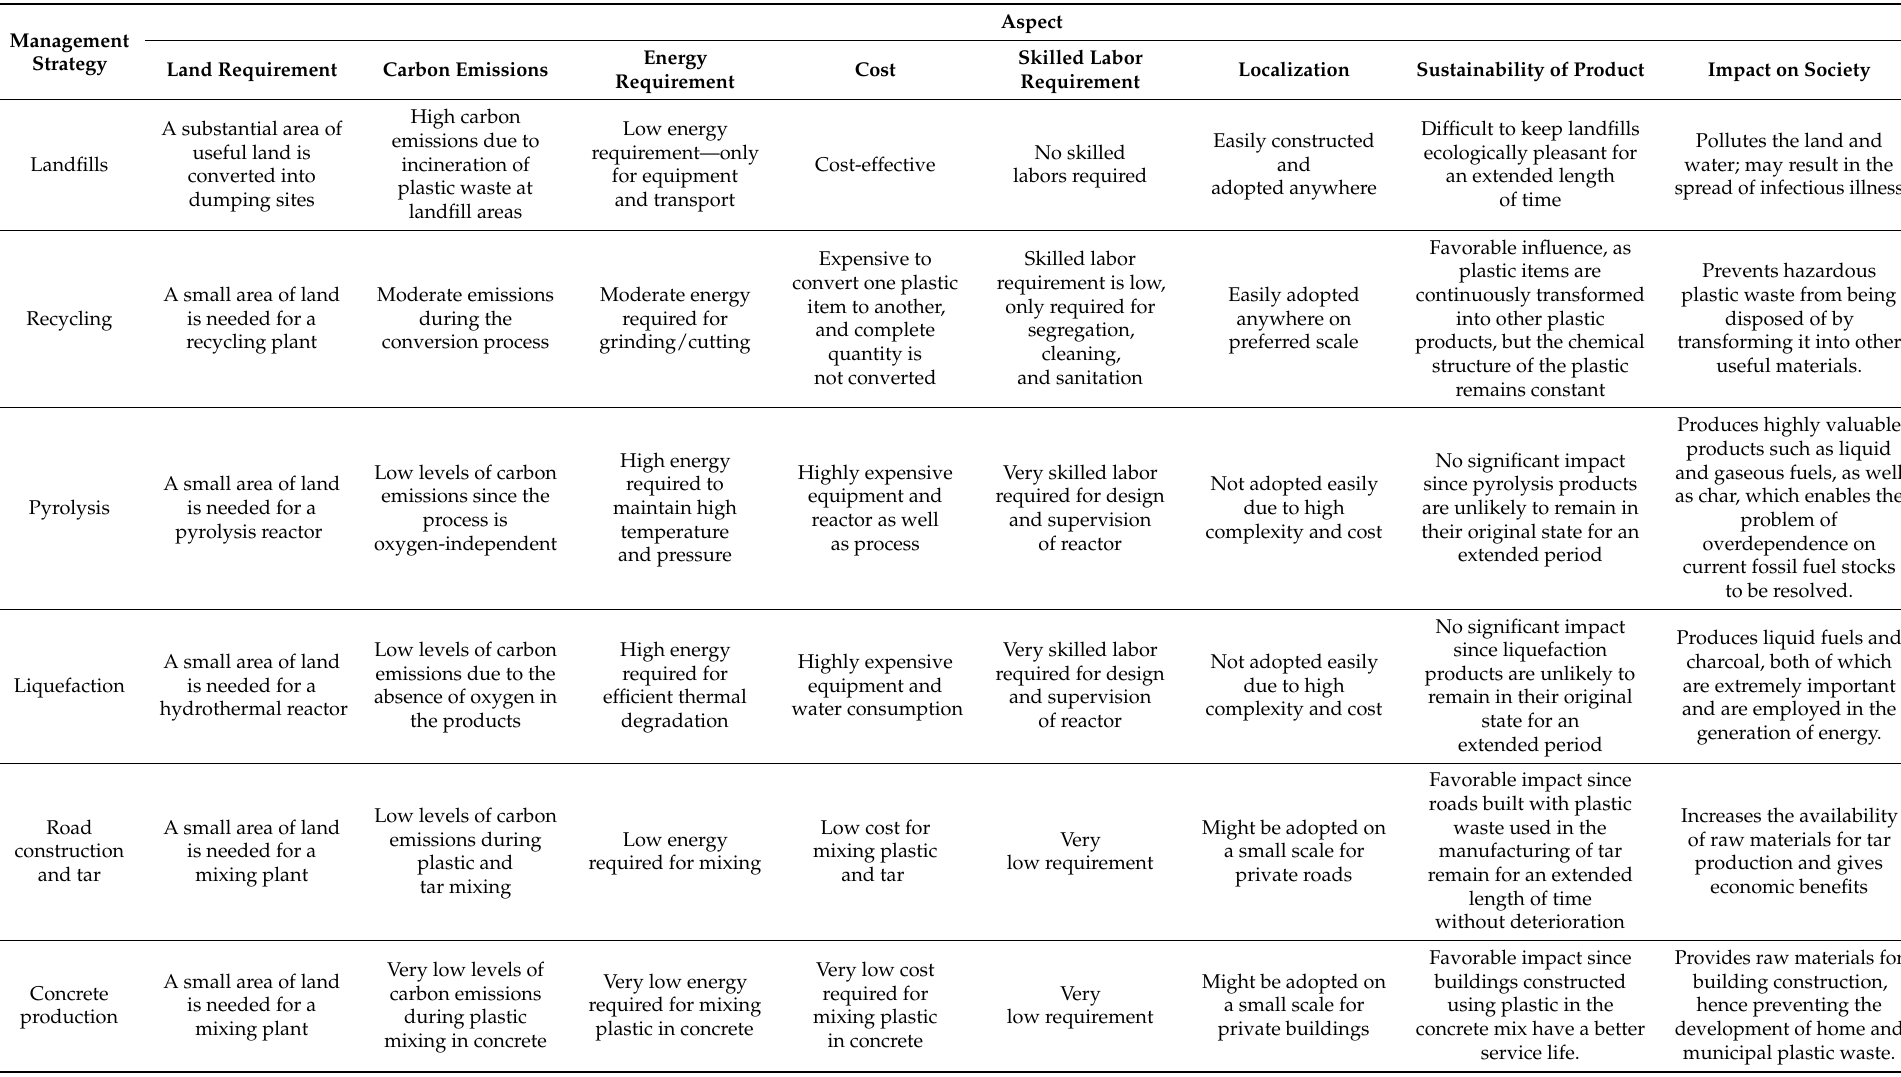
Table 6. The impact of various plastic waste management strategies on different